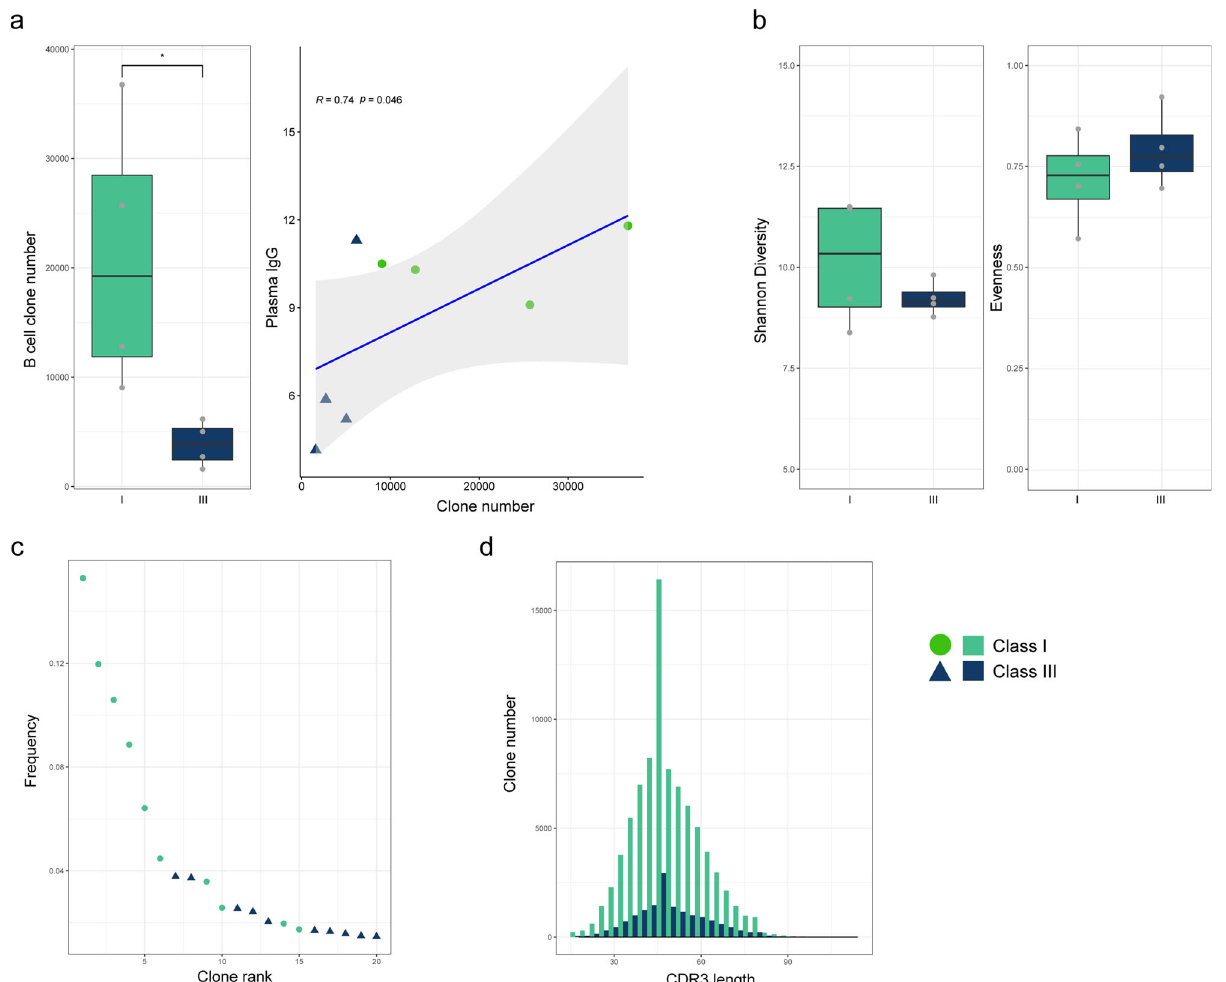
Fig. 3 | B-cell receptor sequencing reveals a more speci fi c antibody response and a higher B-cell clone number in class I patients, whereas class III patients depicted a more diverse response due to polyclonality. a Box plot representa- tionofB-cellclonenumberinclassI( n =4)andclassIIIpatients( n =4)respectively. B-cell clone number was signi fi cantly higher in the blood of class I patients com- pared to class III (Mann – Whitney-U test: p : =0.02857, spearman ’ s rank correlation test: R =0.738, p =0.04583). Class I patients ( n =4) had higher plasma IgG levels which correlated with the number of B-cell clones in the blood. b Box plot repre- sentation of Shannon Diversity and Evenness in class I ( n =4) and class III ( n =4) patients.Diversityanalysisshowedthattherewasnosigni fi cantdifferencebetween classIandII. c RepresentationofallB-cellclonesfromeachclassclusteredtogether and ranked according to their total frequency (relative abundance) in the immune repertoire of a patient. Then, top 10 highest frequency clones from each class